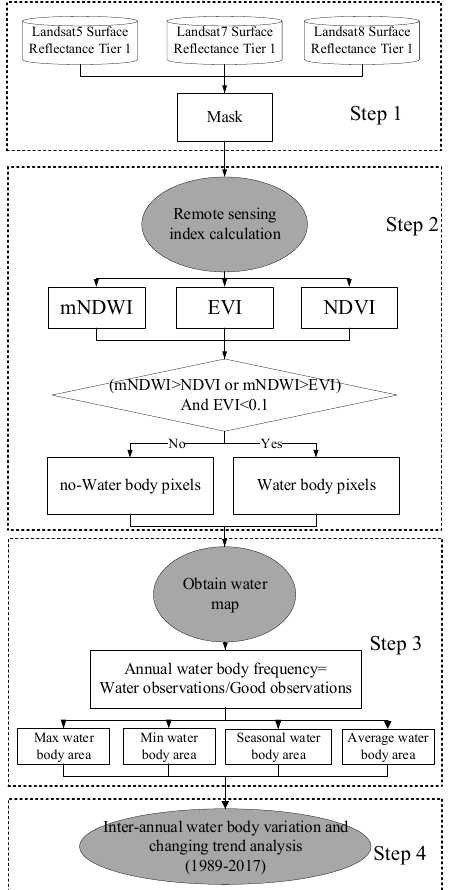
Figure 3. A flowchart of the overall route of open surface water mapping using Landsat 5, 7, and 8 images and Google Earth Engine (GEE).